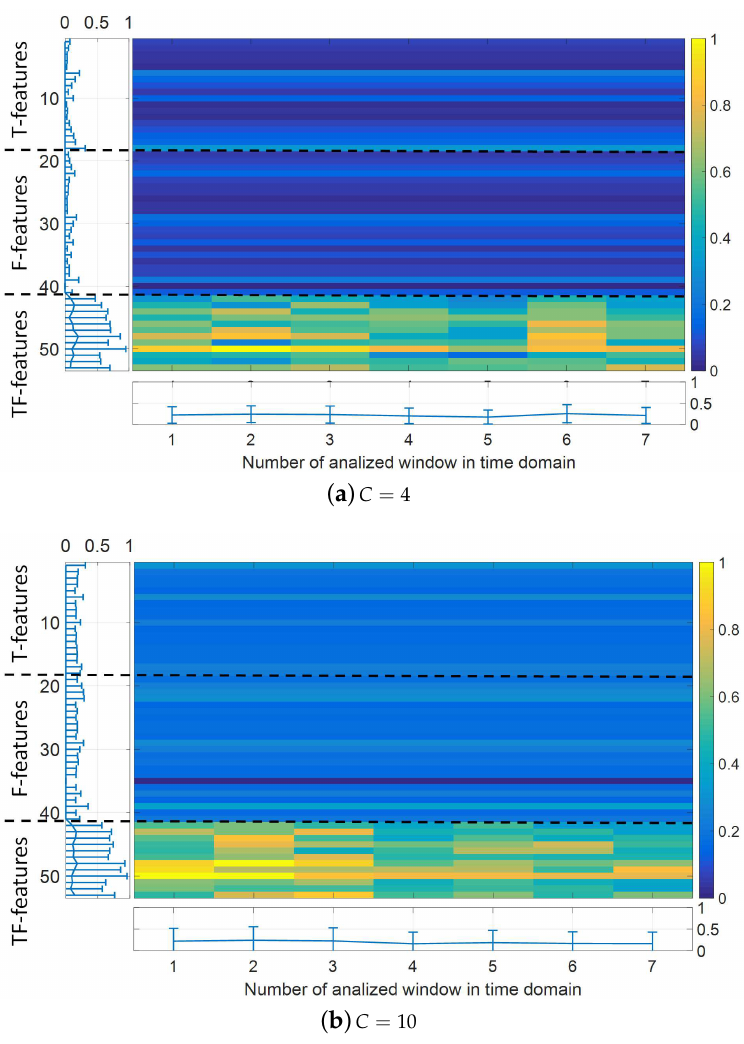
Figure 3. SFS-based relevance values for T, F, and TF domain